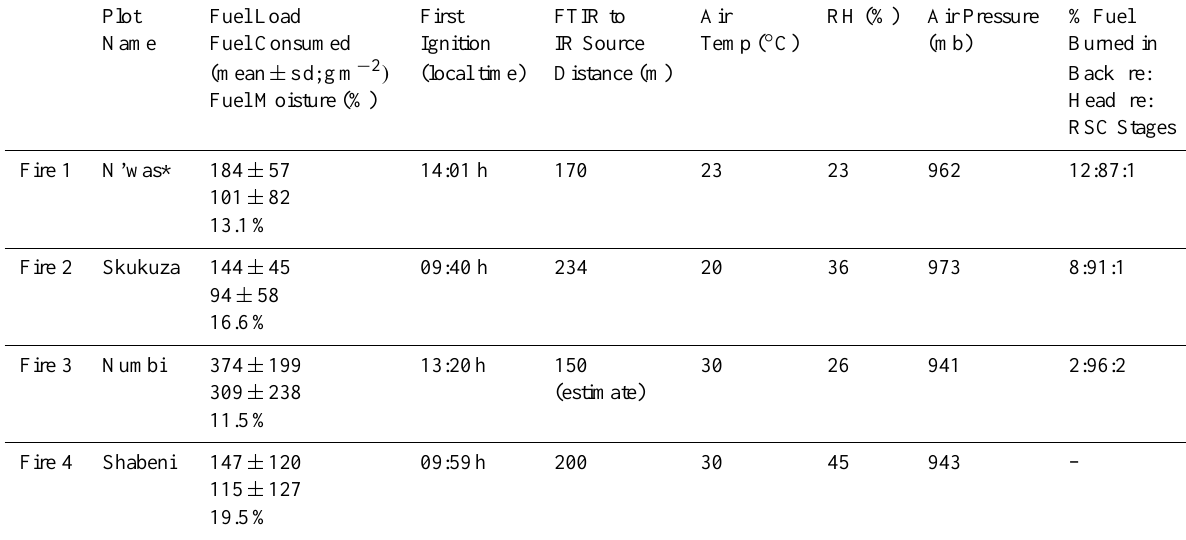
Table 1. Description of the four 7-ha open vegetation fires studied in this work, conducted 27–28 August 2007 at the Kruger National Park (KNP) experimental burn plots detailed in Govender et al. (2006) and located within the latitude-longitude range (25.10–25.16 ◦ S), (31.2– 31.4 ◦ E). The N’waswitshaka and Skukuza plots were located close to Skukuza (25.1097 ◦ S, 31.4172 ◦ E), whist the Numbi and Shabeni plots were located close to Pretoriuskop (25.1639 ◦ S, 31.234 ◦ E). A general description of the KNP geology and vegetation is provided in Scholes et al. (2001), whilst Disney et al. (2011) provide a detailed description of these particular experimental plots. Plot Fuel Load First FTIR to Air RH (%) Air